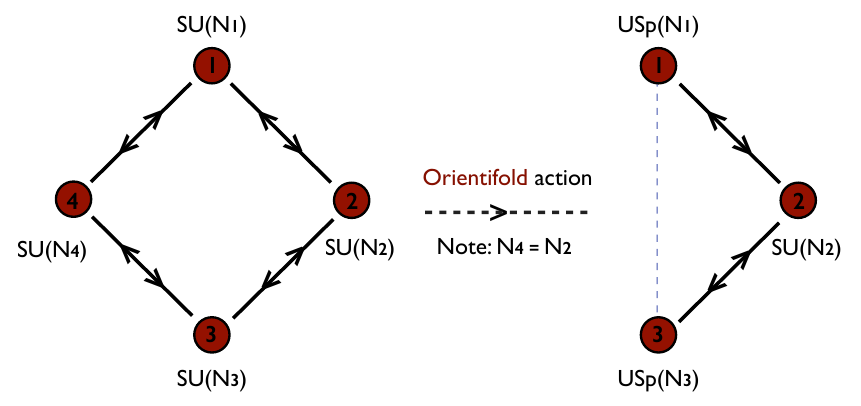
Figure 7 . The non-chiral Z 2 orbifold of the conifold and its